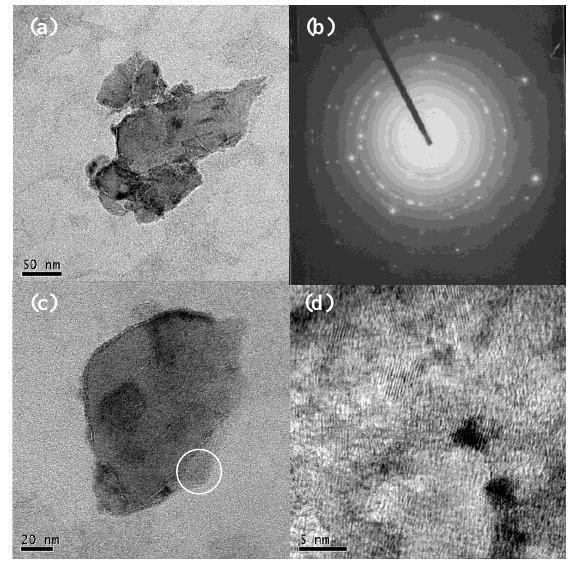
Figure 1. Transmission electron microscopy (TEM) ( a , c ); selected area electron diffraction (SAED) ( b ); and high-resolution TEM (HRTEM) ( d ) images of zirconia-coated nanodiamond (ZrO 2 /ND).